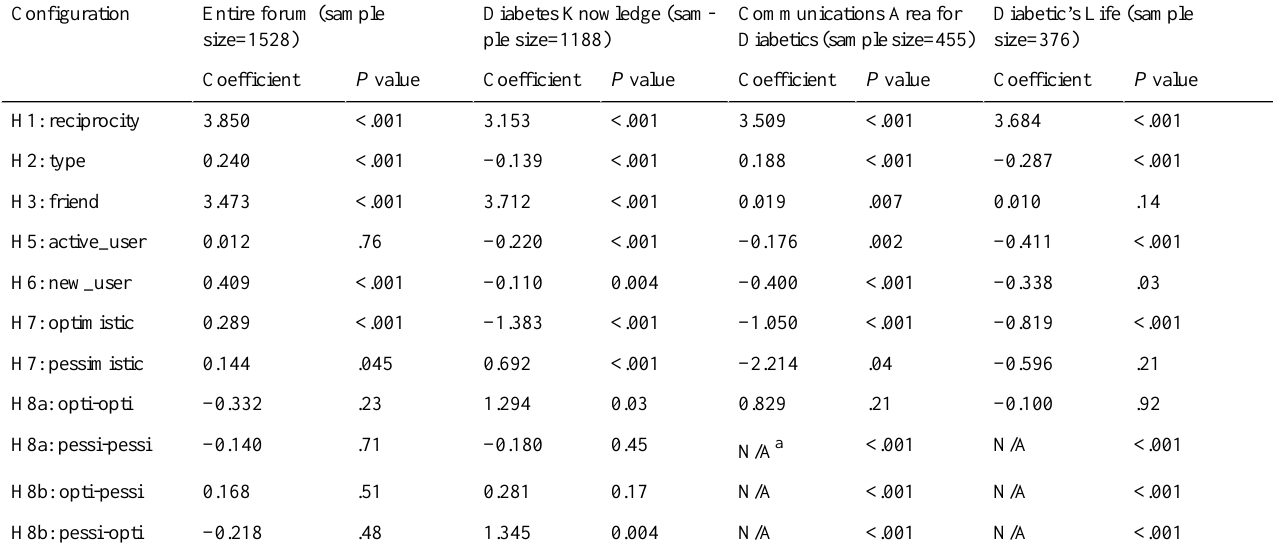
Table 2. Results for exponential random graph model